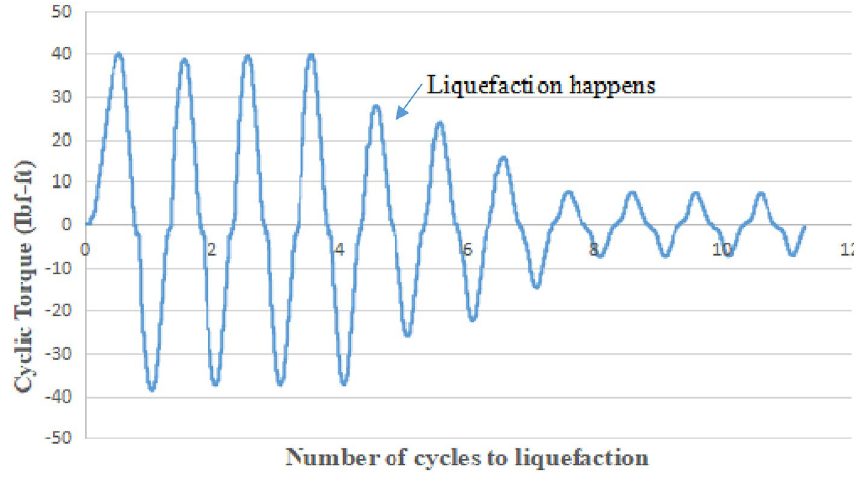
Figure 7. Cyclic torque versus number of cycles to liquefaction in hollow cylinder